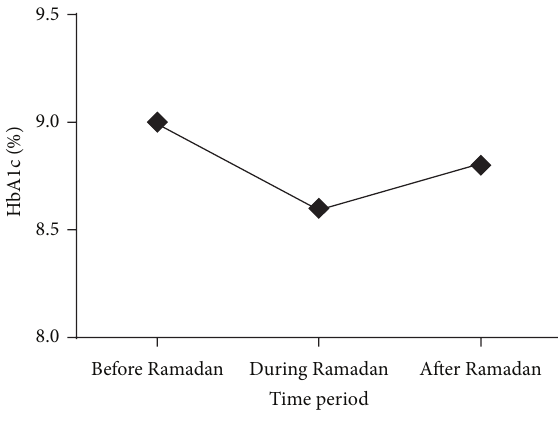
Figure 1: Trends of change in mean